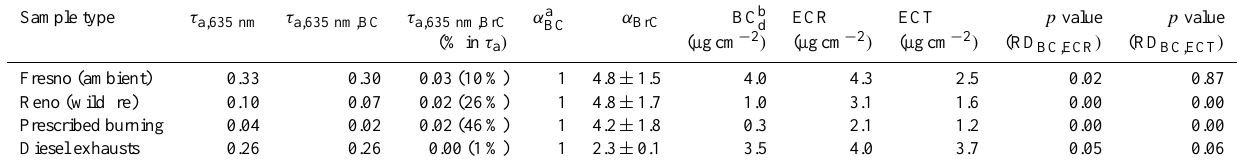
Table 3. Average τ a,635 nm for four sample types and their respective BC and BrC fractions, BrC absorption Ångström exponent, and diesel- EC-equivalent BC (BC d ) concentration. IMPROVE_A ECR and ECT determined by the 635nm optical adjustment are compared to BC d in terms of average and p value of the relative difference